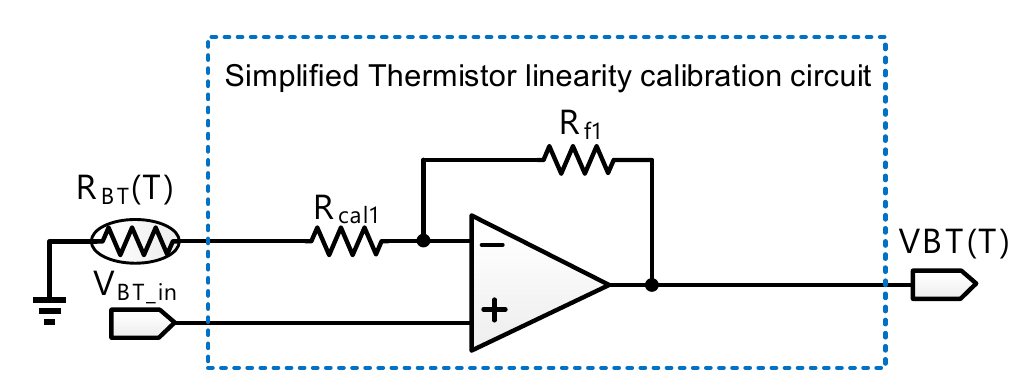
Figure 2. Schematic of thermistor linearity calibration circuit with switches.